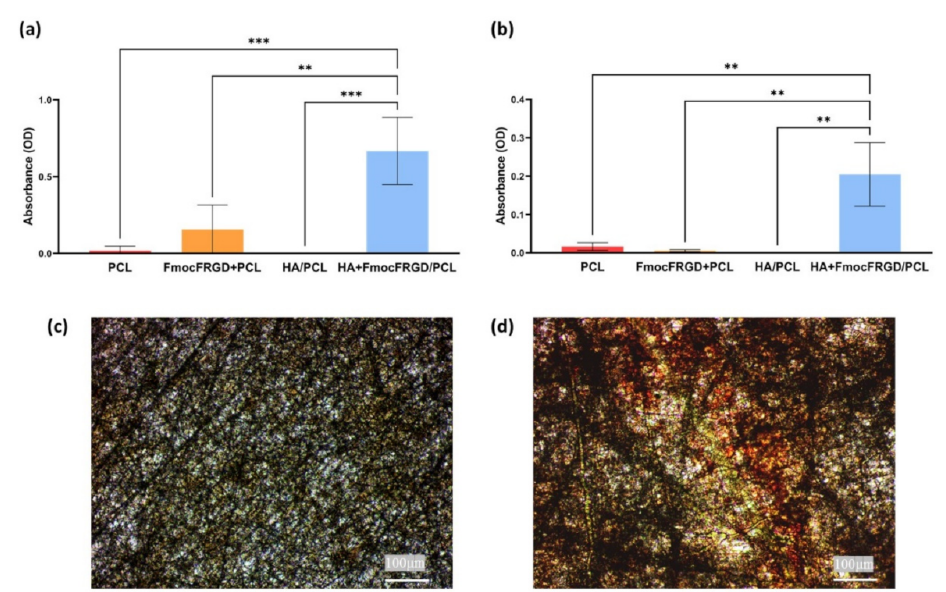
Figure 6. Osteogenesis on HA + FmocFRGD/PCL core/shell electrospun fibers. ( a ) Quantification of Alkaline Phosphatase (ALP) activity of MC3T3-E1 cells, 16 days after seeding with osteogenic differentiation media. ( b ) Quantification of calcification by Alizarin red (AR) staining, 16 days after seeding in osteogenic differentiation media. ( c , d ) Optic microscope images of MC3T3-E1 preosteoblast cells stained with Alizarin red. ( c ) MC3T3-E1 cells 16 days after seeding on PCL fibers. ( d ) MC3T3-E1 cells 16 days after seeding on HA + FmocFRGD/PCL core/shell fibers. Data were analyzed by using a one-way ANOVA. * p < 0.05, ** p < 0.01 and *** p <